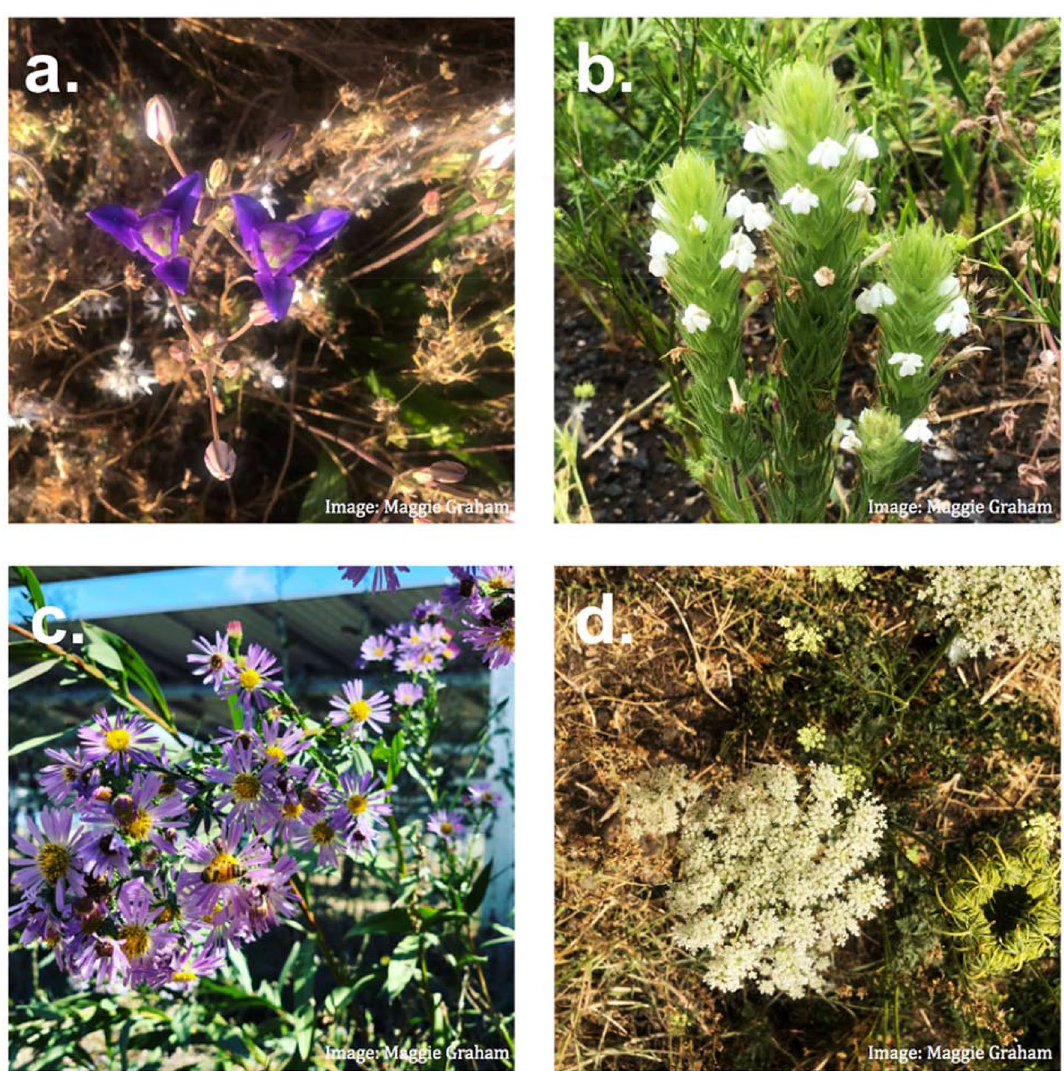
Figure 2. Bloom units are defined by flower morphology. A bloom unit is considered an individual flower for plants with ( a ) distinct, unclustered flowers or ( b ) stems of clustered flowers; a capitulum for plants with ( c ) distinct, composite flowers; and a flower head for plants with ( d ) multiple small, tight